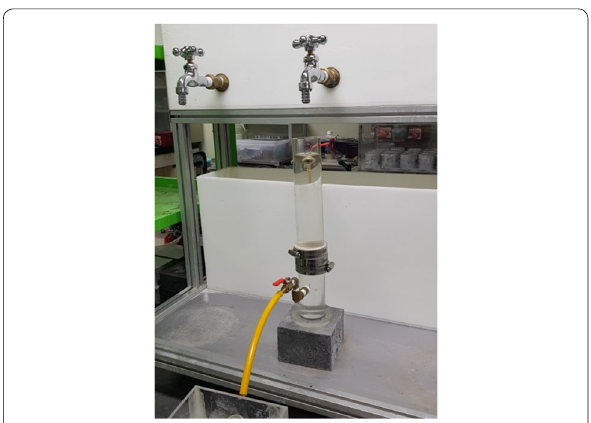
Fig. 3 Water flow test setup.